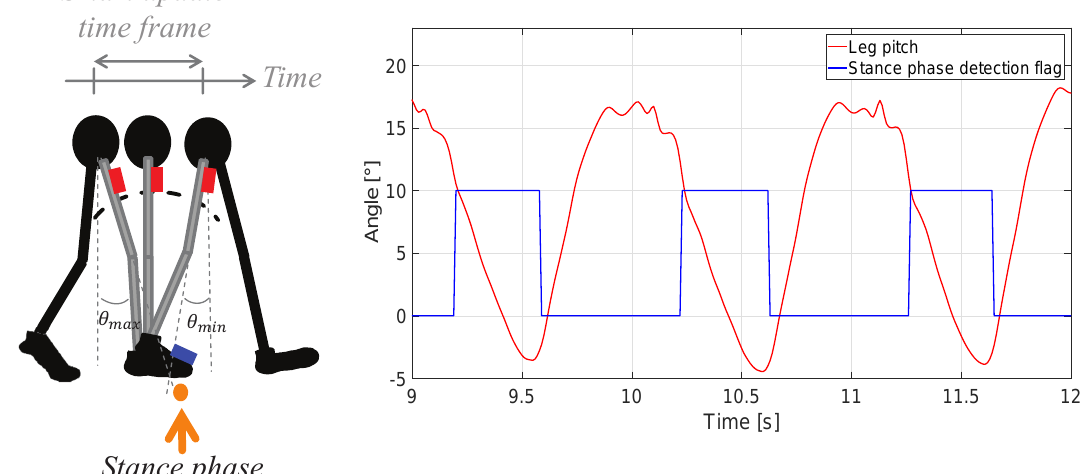
Figure 3. ( Left ) Gait event: stance phase. While the foot is in stance phase, the thigh’s pitch changes from its maximum to it minimum angle while walking; ( Right ) Leg’s pitch estimated and flag for the detection of the foot’s stance phase during three stance phases. The leg’s pitch is estimated by the pocket Inertial Navigation System (INS) and the stance phase flag is estimated by the foot